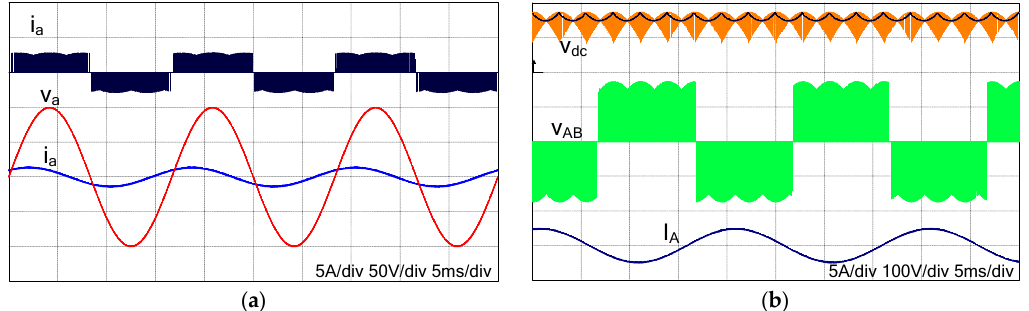
Figure 10. ( a ) Input waveforms; and ( b ) DC ‐ link voltage and output waveforms with the conventional method at m = 0.35 and f out = 50 Hz.